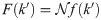
Theoretical fitting of ranked data.Same two examples in Fig 1 of ranked data on earthquakes and forest fires fitted with the expressions in Eqs (9) and (10). (a) Size-rank distribution N(k) for earthquakes. (b) Frequency-rank distribution for earthquakes (with F(k′)=Nf(k′)). (c) Size-rank distribution N(k) for forest fires. (d) Frequency-rank distribution for forest fires (with F(k′)=Nf(k′)). As can be seen, the values of α needed for fitting are close to α = 2 that corresponds to the classical Zipf law exponent. See text for description.